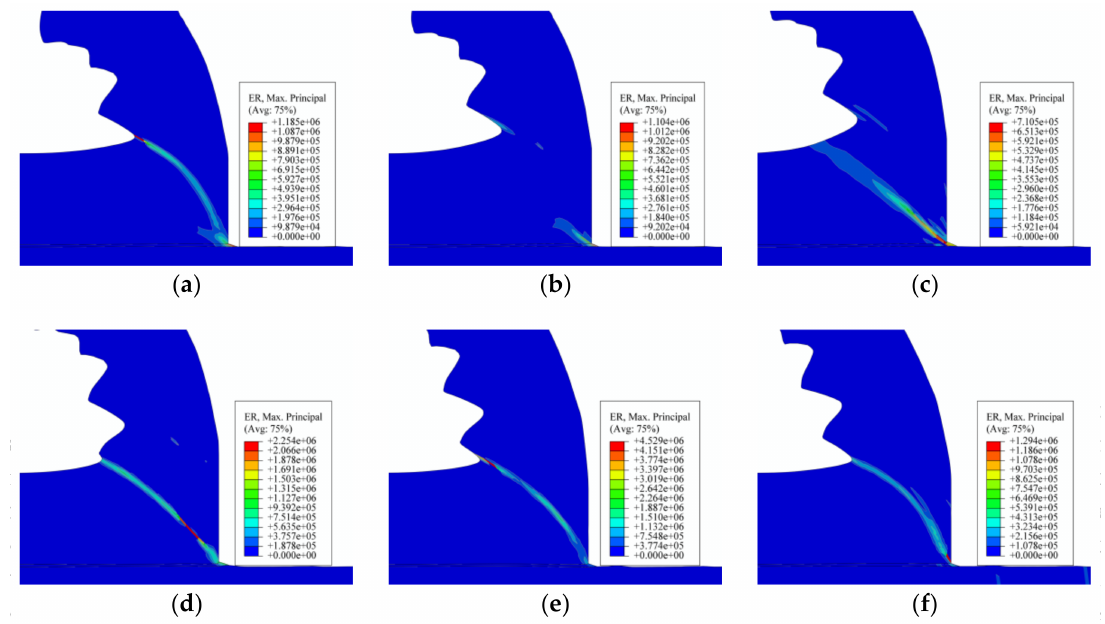
Figure 16. Strain rate under condition of v s = 450 m/min, f r = 0.2 mm/r: ( a ) the fully formed saw-tooth segments; ( b ) the new segment began to form; ( c ) the development of the shear plane; ( d ) adiabatic shear instability in the shear plane; ( e ) shearing slip of the chip material; and ( f ) the new saw-tooth segment was fully